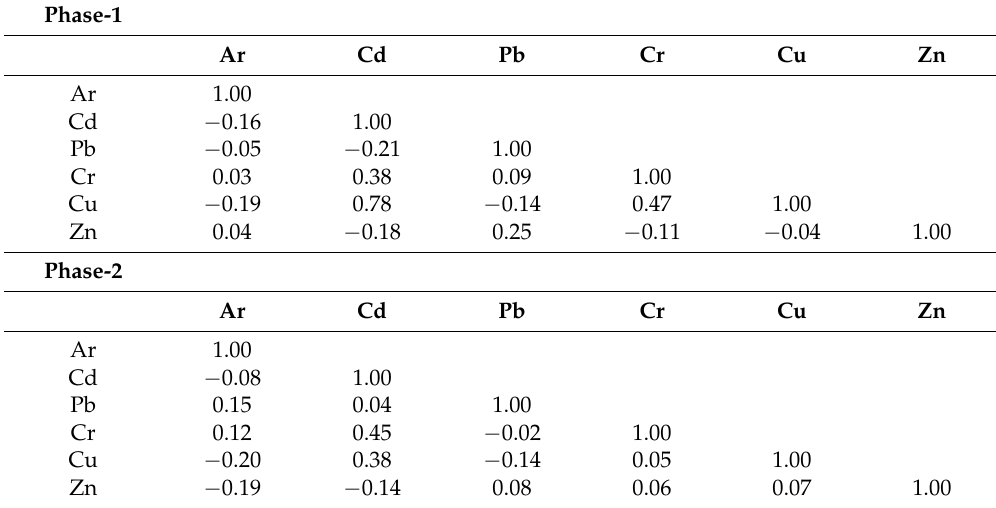
Table A2. Correlation matrix for heavy metals parameters in the two phases.